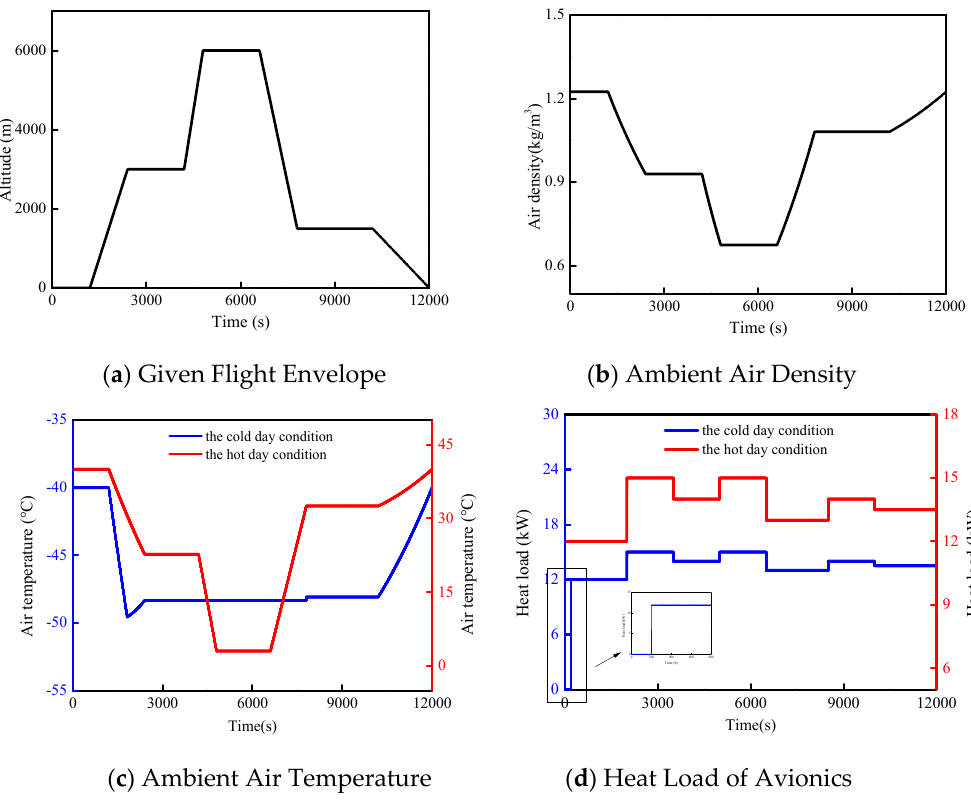
Figure 14. Simulation conditions.